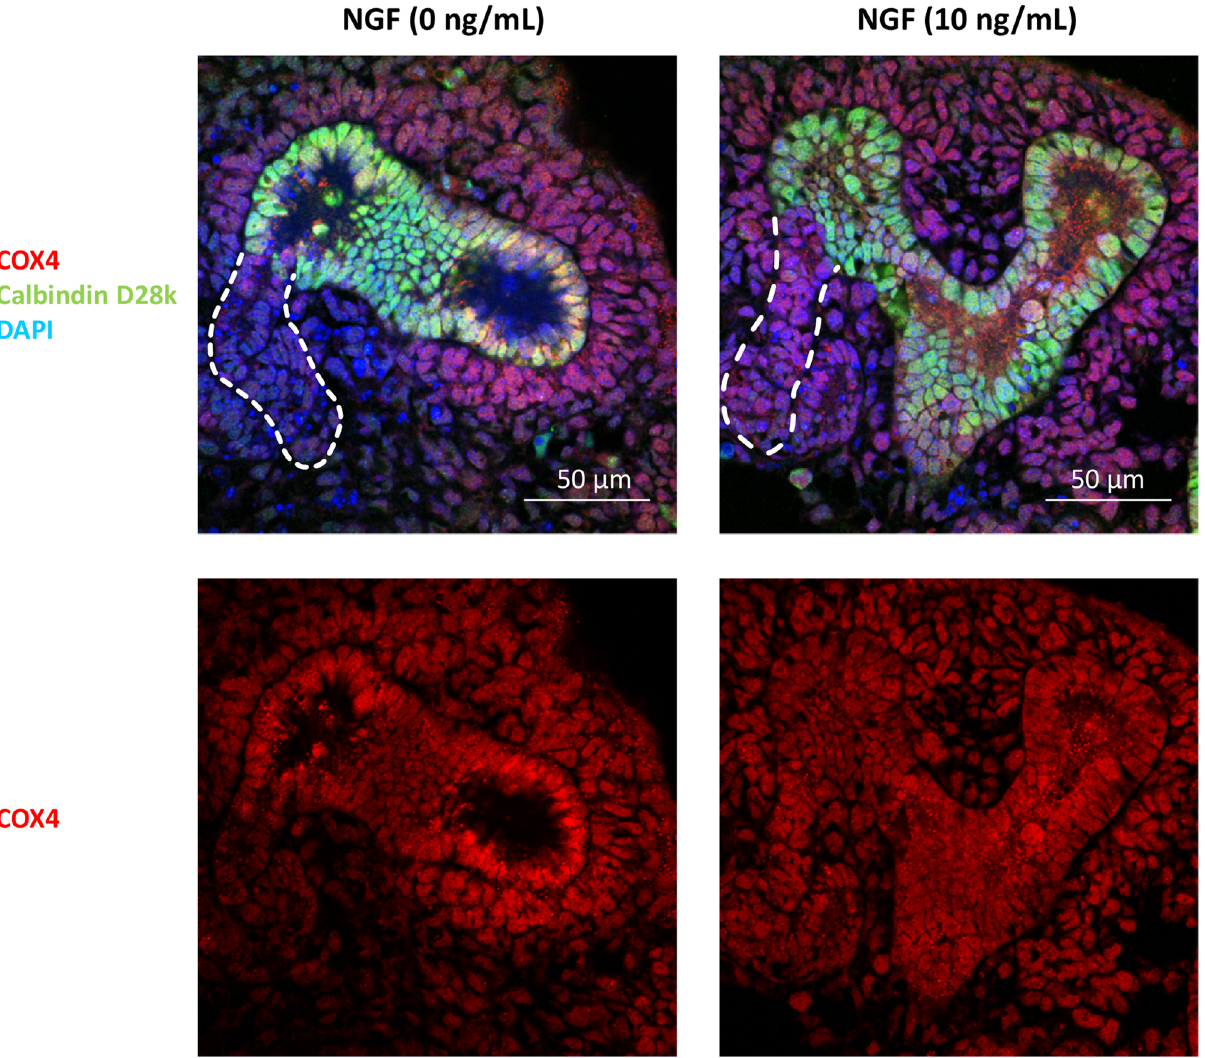
Figure 7. Nerve growth factor (NGF) increases mitochondrial biogenesis in embryonic distal tubules. Embryonic mouse kidneys cultured in the presence or absence of NGF (10 ng/mL) for 24 hours were analyzed. Sections were immunohistochemically stained with cytochrome c oxidase polypeptide IV (COX4), a marker of mitochondria, in red, calbindin D28k in green, and DAPI in blue (scale bar: 50 µm). Dotted white lines indicate distal